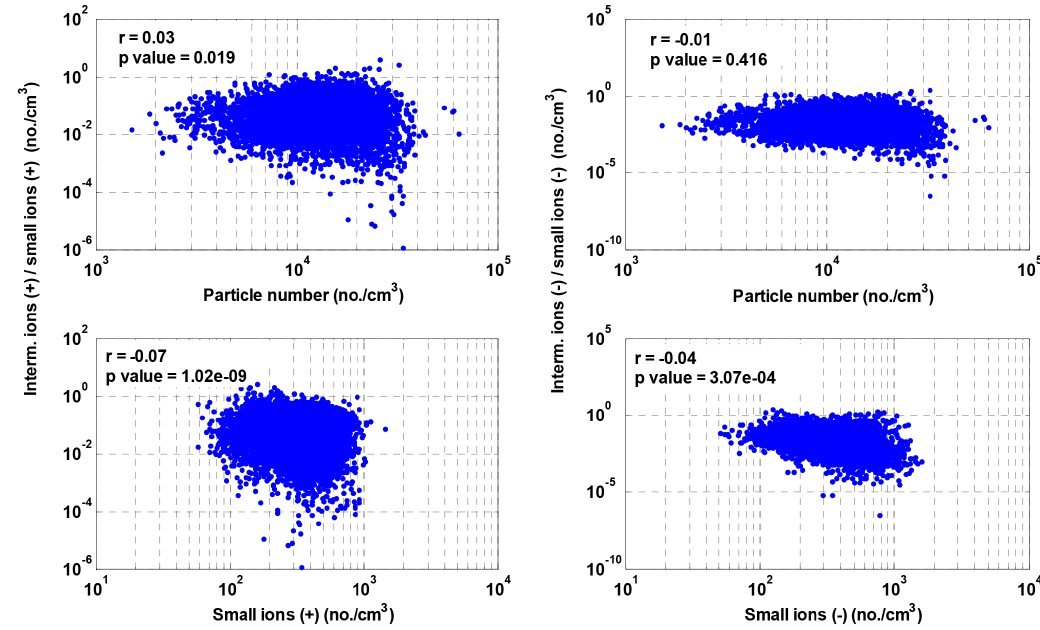
Figure A6. Correlation between the ratio intermediate ions/small ions and particle number and small